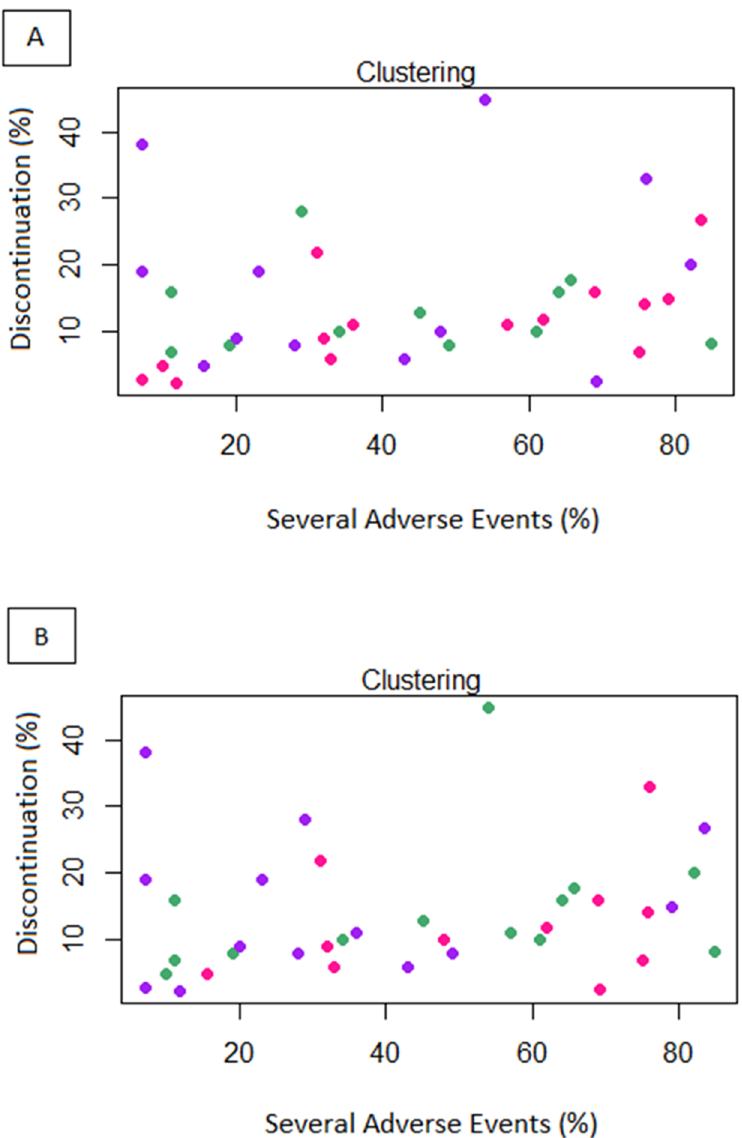
Fig 4. Cluster analysisbasedon Euclideandistanceconsidering the drug costs for 1-month (A) or for the mediantotal durationof therapy (B) for a singleoncologicalpatient. Green points represent drugs with low cost (Group A), violet points drugs with medium cost (Group B) and pink with high cost for 1-month of treatment (Group C).